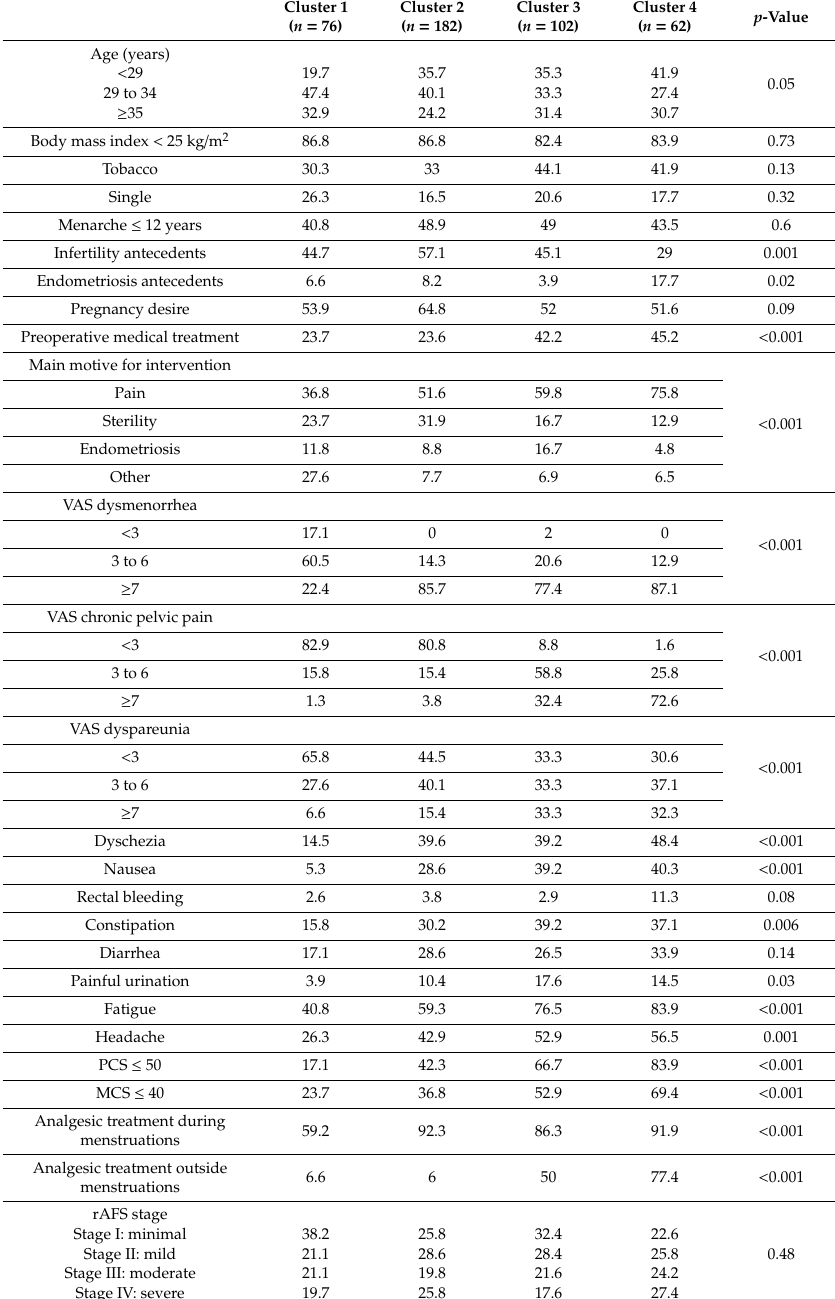
Table 3. Characteristics of the four clusters obtained by multiple correspondence analysis. Data are presented as